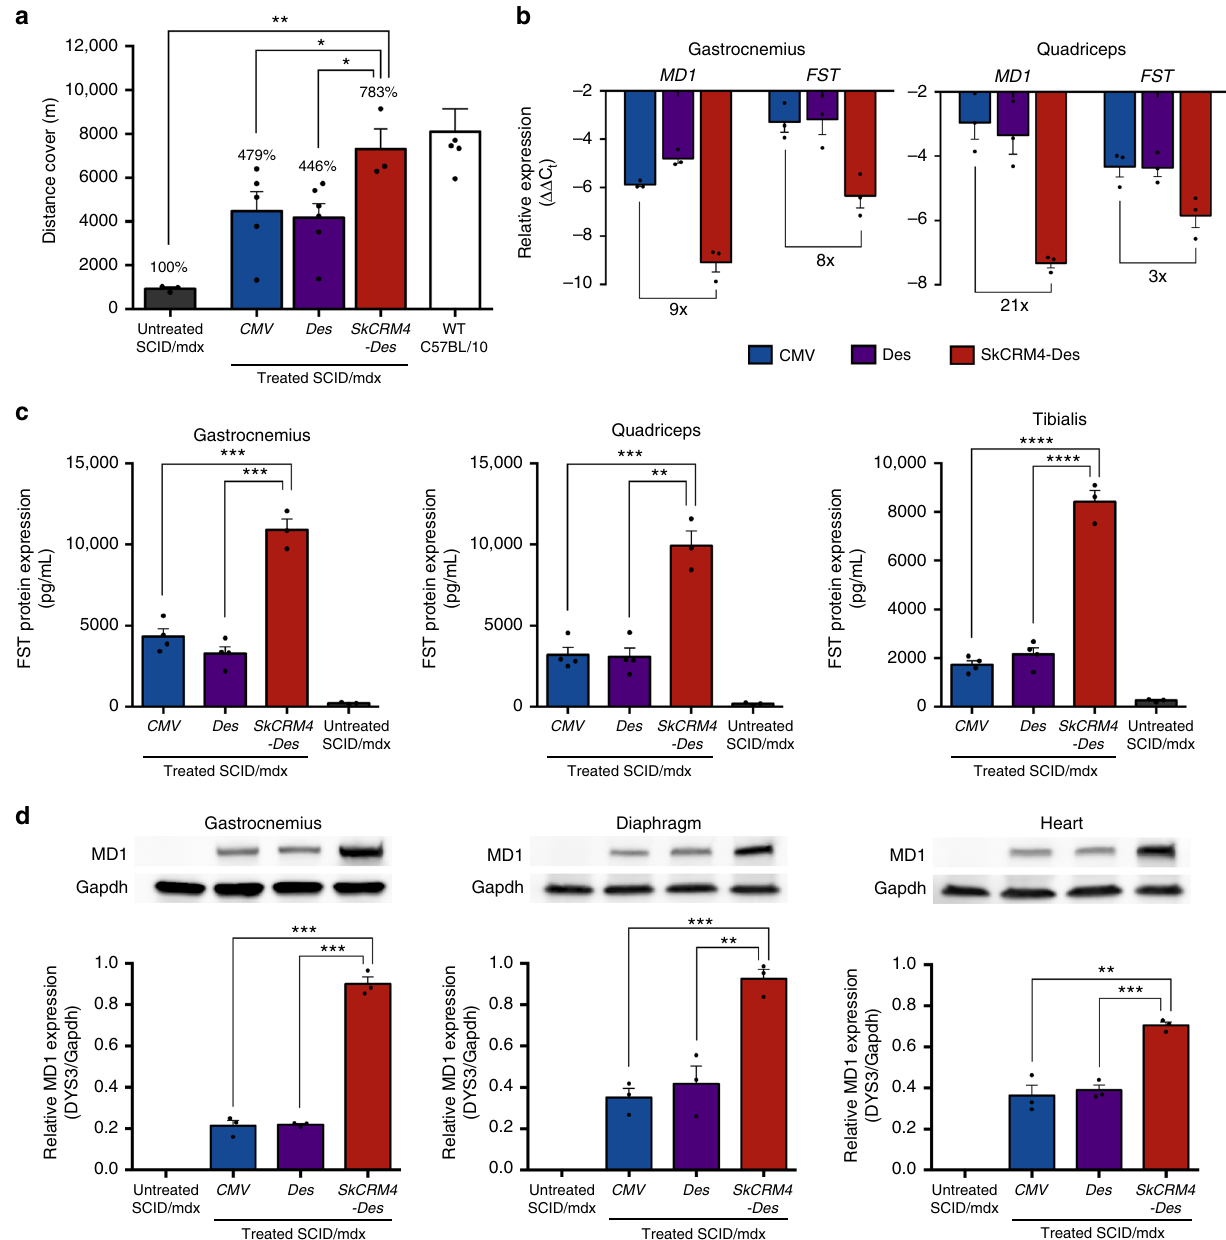
Fig. 7 Comparison of Sk-CRM4/Des chimeric promoter with conventional promoters in SCID/mdx. The ssAAV9 vectors encoding MD1 and FST under the control of the Sk-CRM4/Des chimeric promoter, Des , or CMV conventional promoters were co-injected into SCID/mdx mice at a dose of 1 × 10 11 vg/mouse for each vector. a Physical performance of the 16 weeks post-injected SCID/mdx mice treated with the different therapeutic vectors compared to the untreated age-matched control SCID/mdx and wild-type C57BL/10ScSnJ mice were determined by measuring the distance covered. Results were presented as mean ± standard error of the mean ( n = 3 – 6). The percentages on the top indicate the distance related to untreated SCID/mdx mice. b Human MD1 and FST mRNA quanti fi cation in skeletal muscles (i.e., gastrocnemius and quadriceps) of treated SCID/mdx mice, expressed relative to the housekeeping gene Gapdh by qRT-PCR. The Gapdh protein levels were used as loading control for normalization. c Quanti fi cation of human FST protein (in pg/50 mg of skeletal muscle tissues) as determined by ELISA. d Western blot analysis of MD1 protein expression in heart, diaphragm and skeletal muscle ( gastrocnemius ) of treated and control SCID/mdx. The protein expression levels of MD1 were detected using a dystrophin-speci fi c (DYS3) antibody. Statistical analysis using t -test * p < 0.05; ** p < 0.01; *** p < 0.001, **** p < 0.0001; mean + s.e.m. ( n = 3 –